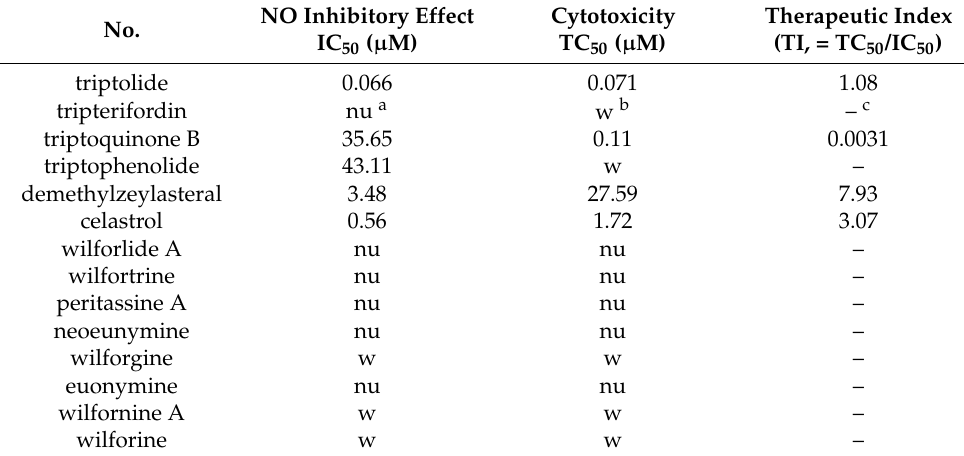
Table 7. NO inhibitory effects of investigated compounds in LPS-induced RAW 264.7 cells and their cytotoxicities against RAW